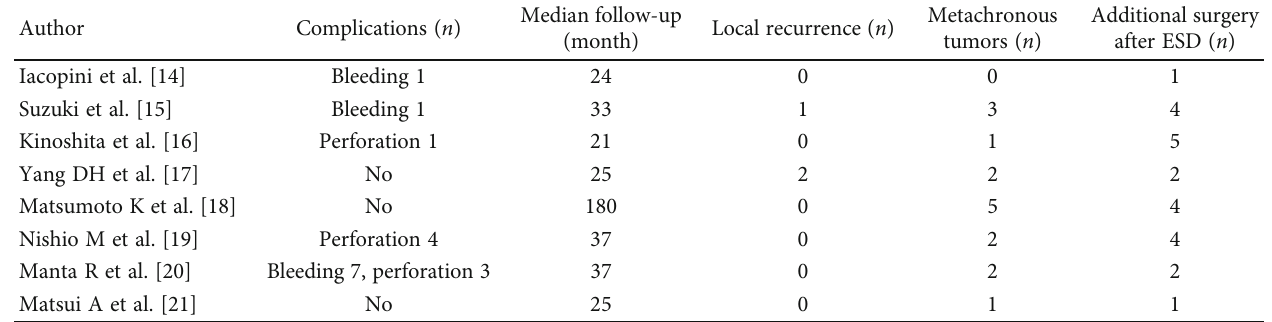
Table 3: Complications and follow-up results in the collected studies.